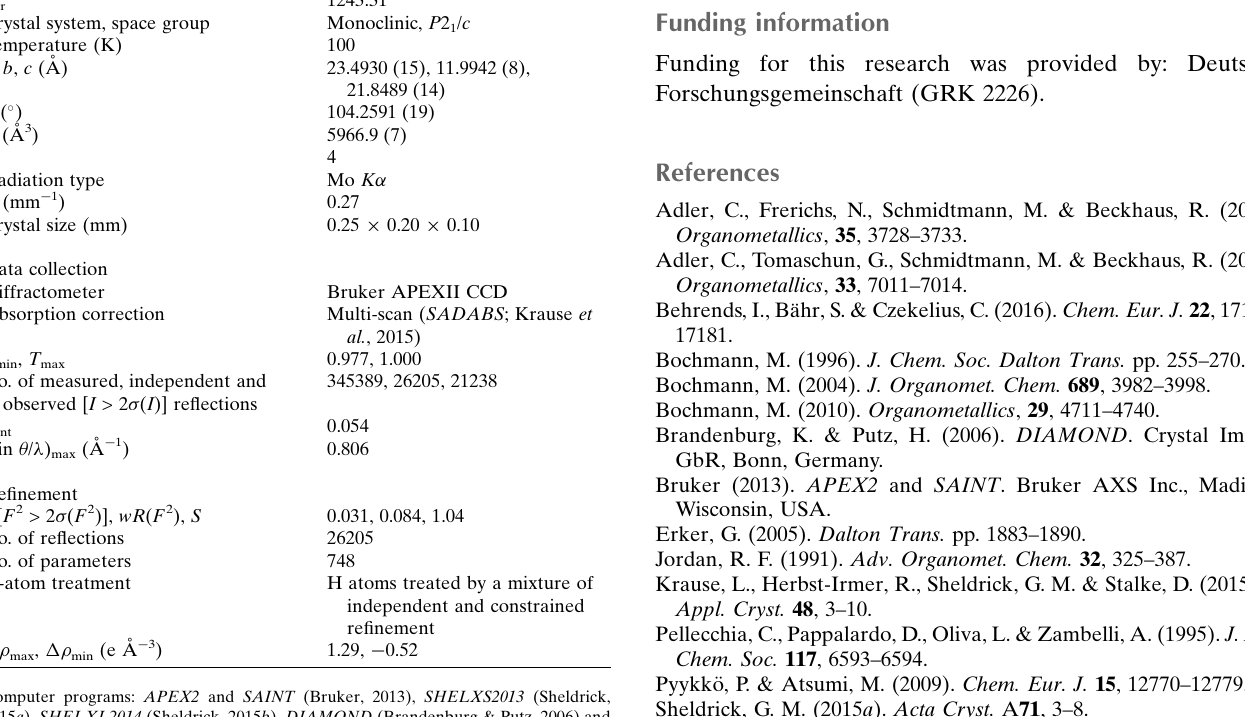
Crystal data Chemical